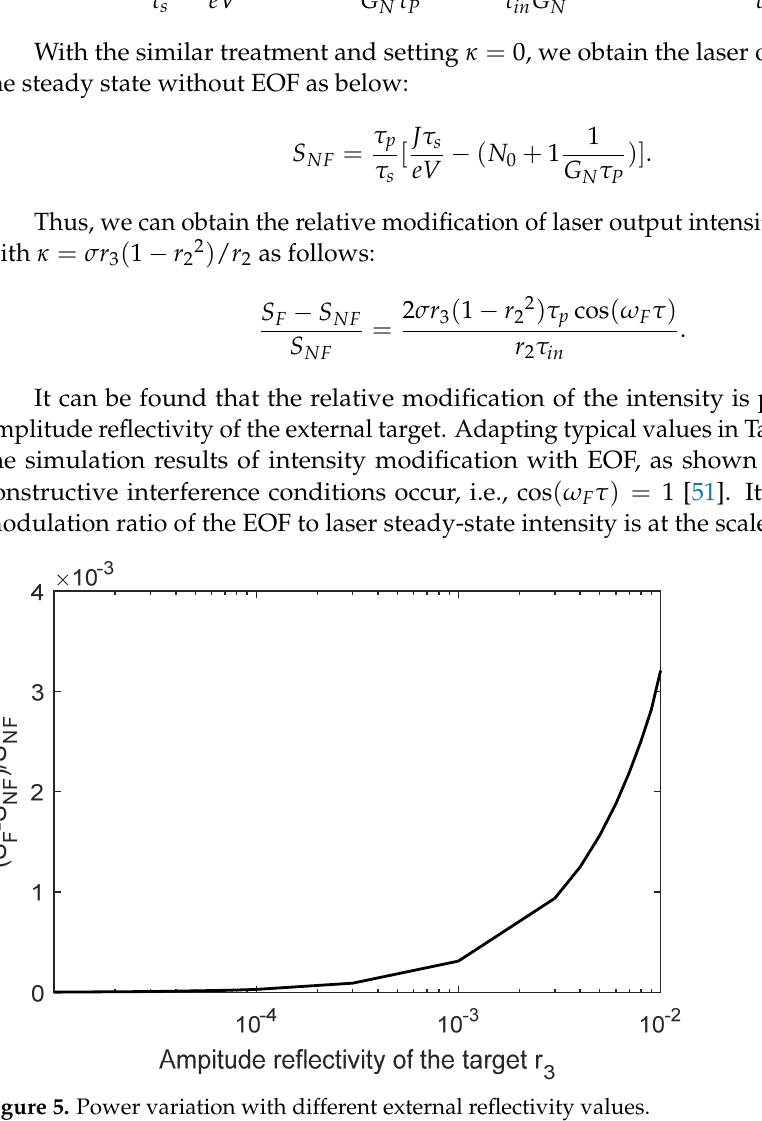
Figure 5. Power variation with different external reflectivity values.